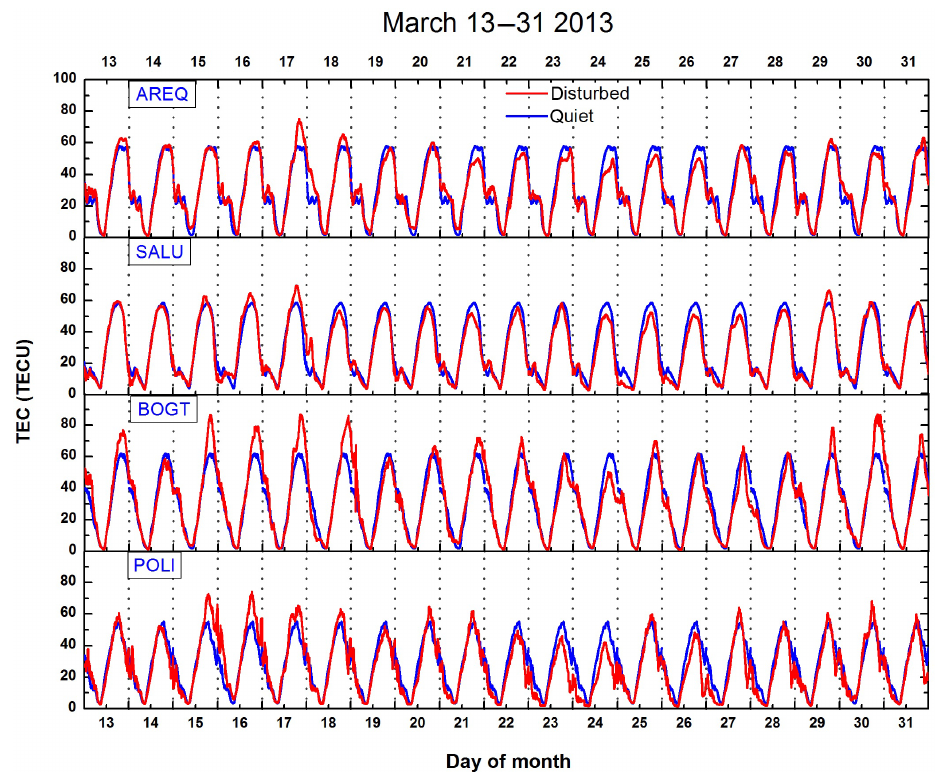
Figure 3. TEC measured over the equatorial GPS stations Areq and Salu, and the EIA crests stations Bogt (north) and Poli (south), for the period 13–31 March 2013. The blue line shows the quiet-time reference values (average of 6 previous quiet days) and the red line shows the disturbed